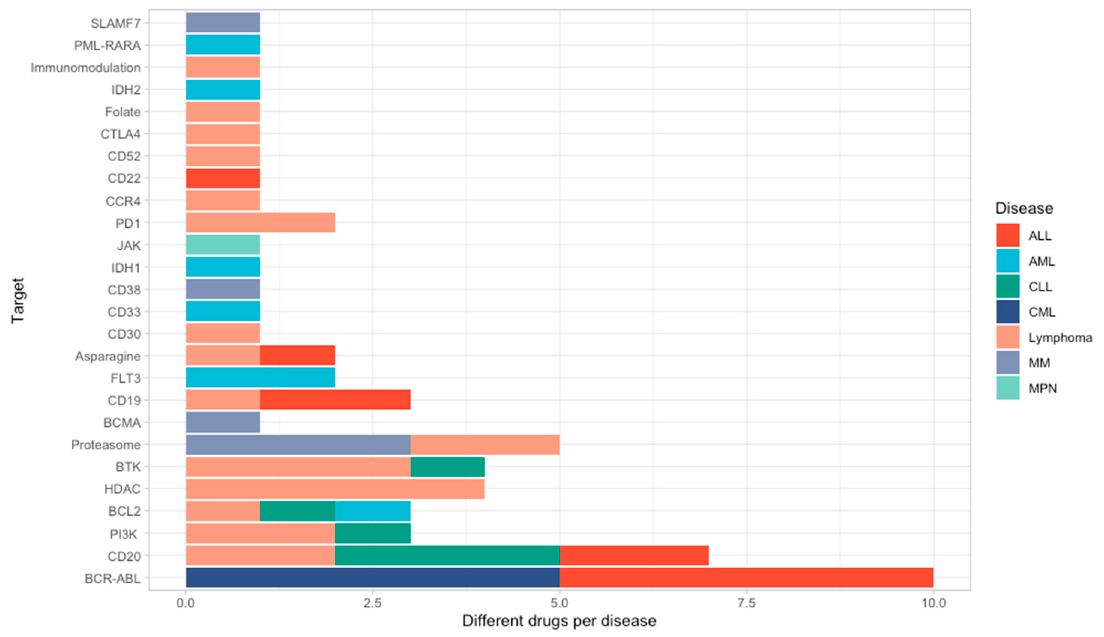
Figure 1. Targets of different FDA-approved and non-approved drugs across different hematological disorders; Legend: acute lymphoblastic leukemia (ALL); acute myeloid leukemia (AML), chronic lymphocytic leukemia (CLL), chronic myeloid leukemia (CML), multiple myeloma (MM), myeloproliferative neoplasm (MPN).